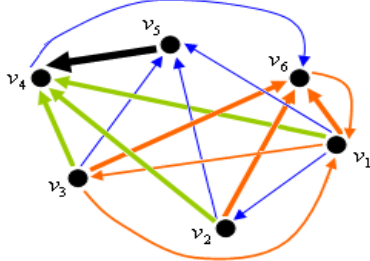
Figure 5. A FACS clinical waste incineration process [10].